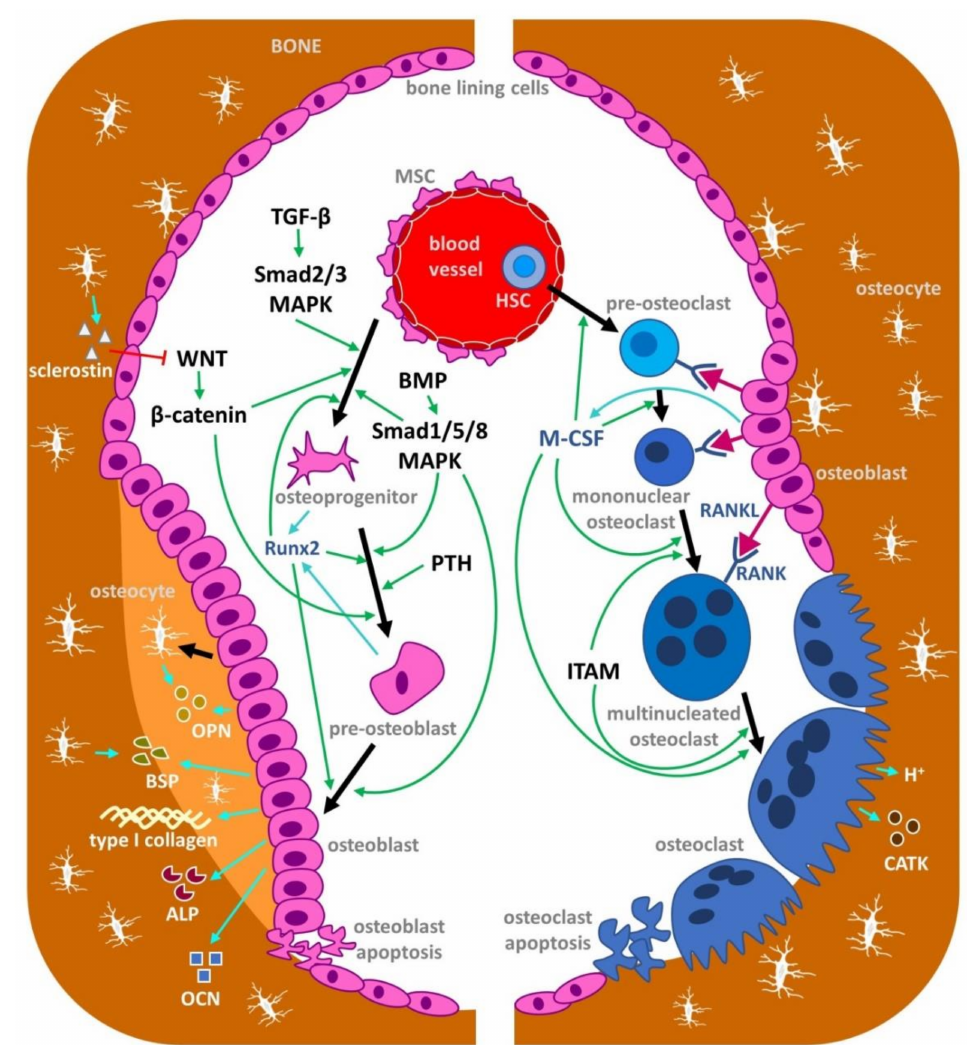
Figure 1. Schematic representation of osteoblast (left) and osteoclast (right) differentiation with the involvement of selected important signaling pathways and regulators. Positive effects are depicted by green arrowheads. The blue arrows and font show the production of selected molecules important in the signaling pathway and also for the processes of bone formation and resorption. Osteoblastogenesis is regulated by different signaling pathways (including TGF- β /BMP, WNT), resulting in activation of downstream transcription factors such as Runx2 and leading to the expression of osteoblastogenic markers by osteoblasts, e.g., type I collagen, ALP, OPN, BSP and OCN. The canonical WNT pathway activates downstream signaling cascades, resulting in β -catenin translocation into the nucleus which enhances osteoblastogenic target gene expression. TGF- β and BMPs are secreted growth factors belonging to the TGF- β superfamily, which play an essential role in development, tissue homeostasis and regeneration. Canonical TGF- β signaling mobilizes transcription factors Smad2 and Smad3 to interact with other transcription factors and induces Runx2-mediated gene expression. Similar to TGF- β , canonical BMP signaling also transmits signals through Smad transcription factors. Moreover, BMPs and TGF- β can induce Runx2 through the MAPK signaling pathway. Osteocytes represent a differentiated stage of the osteoblast lineage and they have key regulatory roles in bone and mineral homeostasis. Osteoclasts differentiate from cells of the monocyte/macrophage lineage in response to the osteoclastogenic cytokines M-CSF, RANKL and ITAM. As a result, mononuclear osteoclast precursors finally fuse into mature polykaryons which produce protons and proteolytic enzymes (especially cathepsin K) to dissolve bone minerals and degrade bone matrix proteins. MSC, mesenchymal stem cell; TGF- β , transforming growth factor beta; BMP, bone morphogenetic